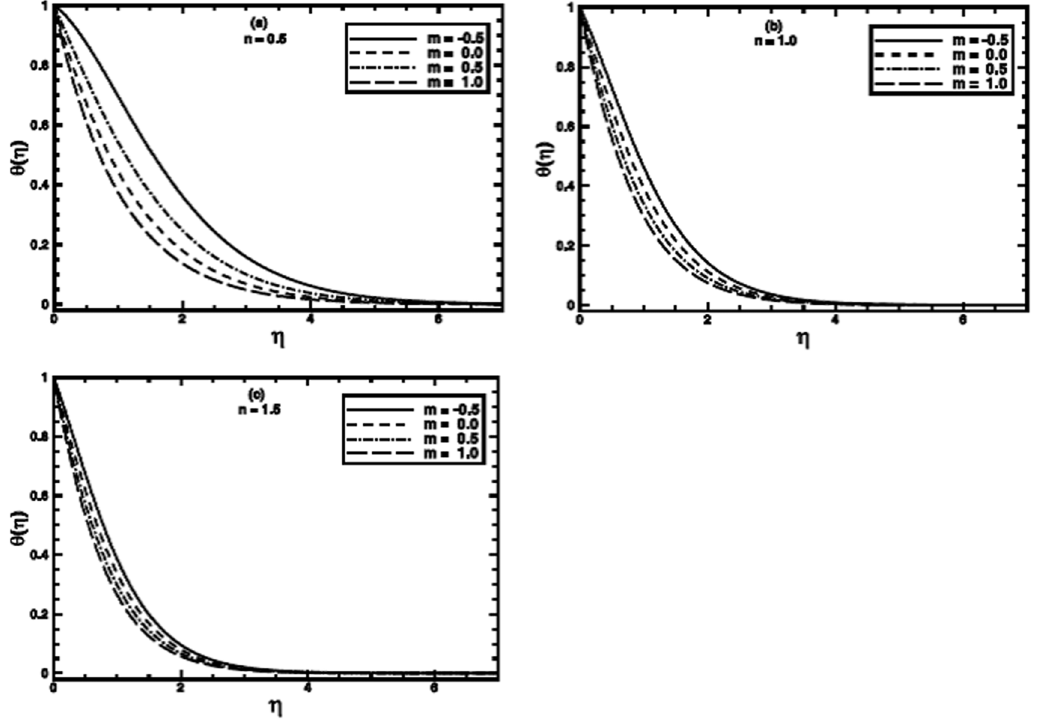
Figure 7. The temperature profile h g ð Þ in the PST case for different values of the temperature parameter m when s ~ 1 : 5 , Pr ~ 1 and A ~ 1 are fixed. doi:10.1371/journal.pone.0100056.g007 PLOS ONE |